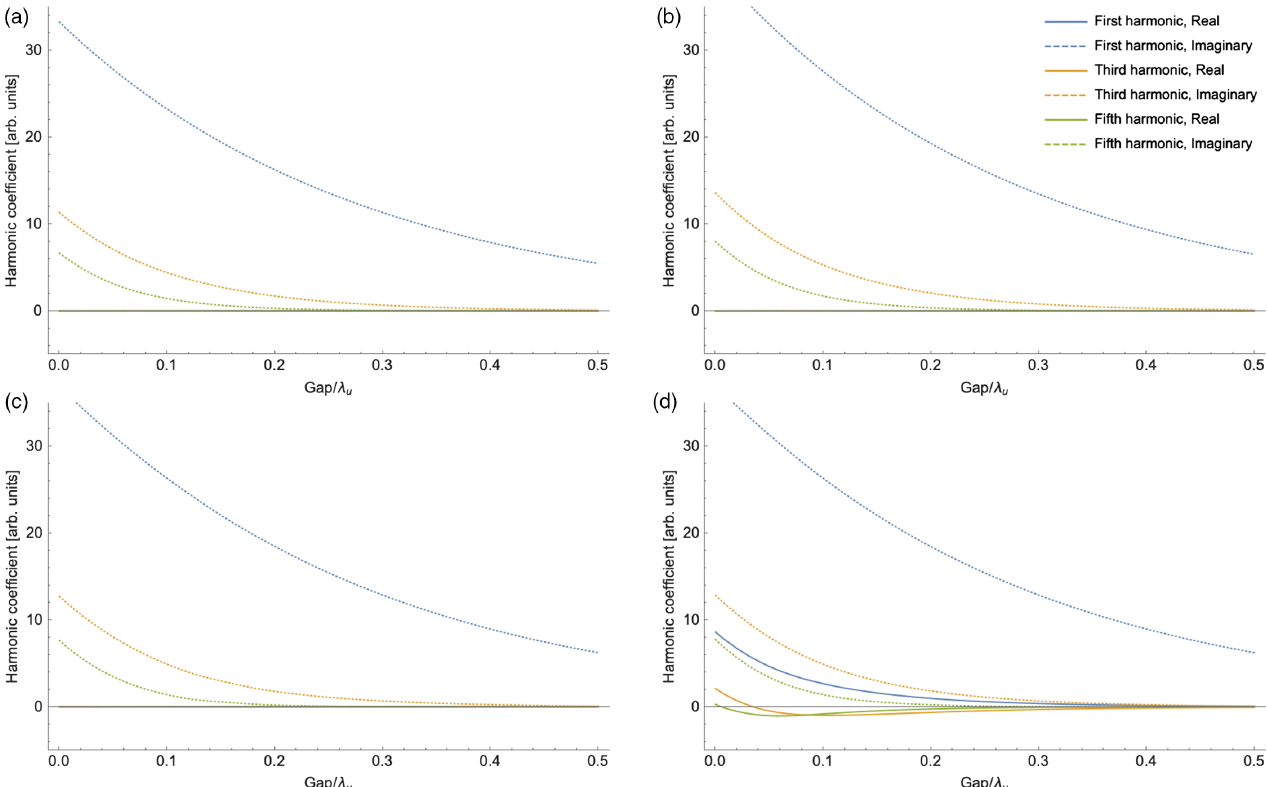
FIG. 3. Harmonic coefficients of the on axis field for (a) M 0 ¼ 2 , (b) isosceles triangle, (c) rotation symmetric right triangle, and (d) reflection symmetric right